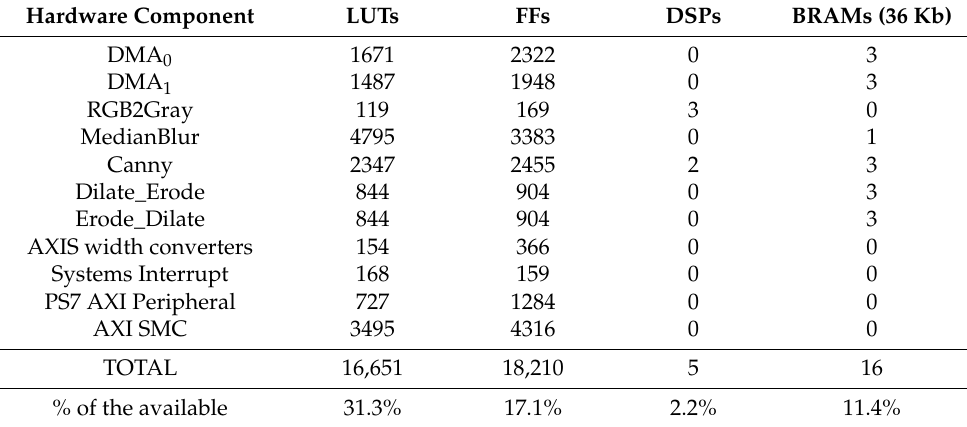
Table 1. Hardware resource utilization.